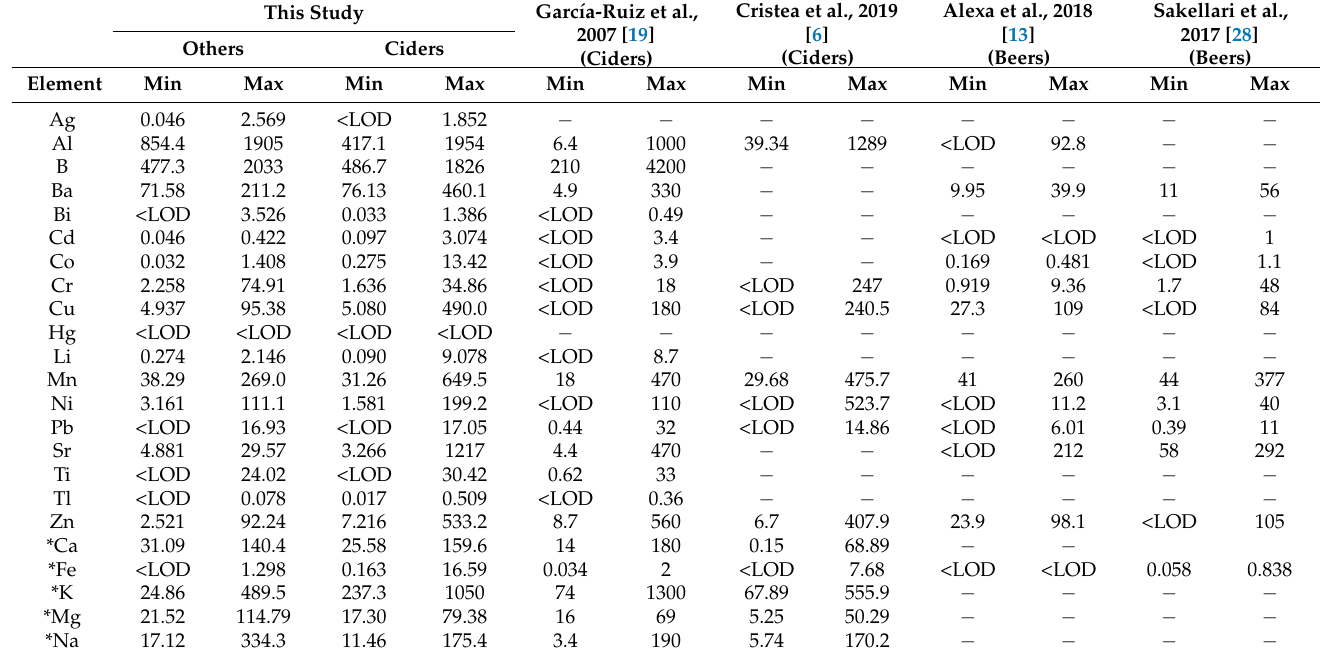
Table 5. Comparison ranges of selected elements in ciders [6,19] and beers [13,28] indicated in other papers with results obtained in this